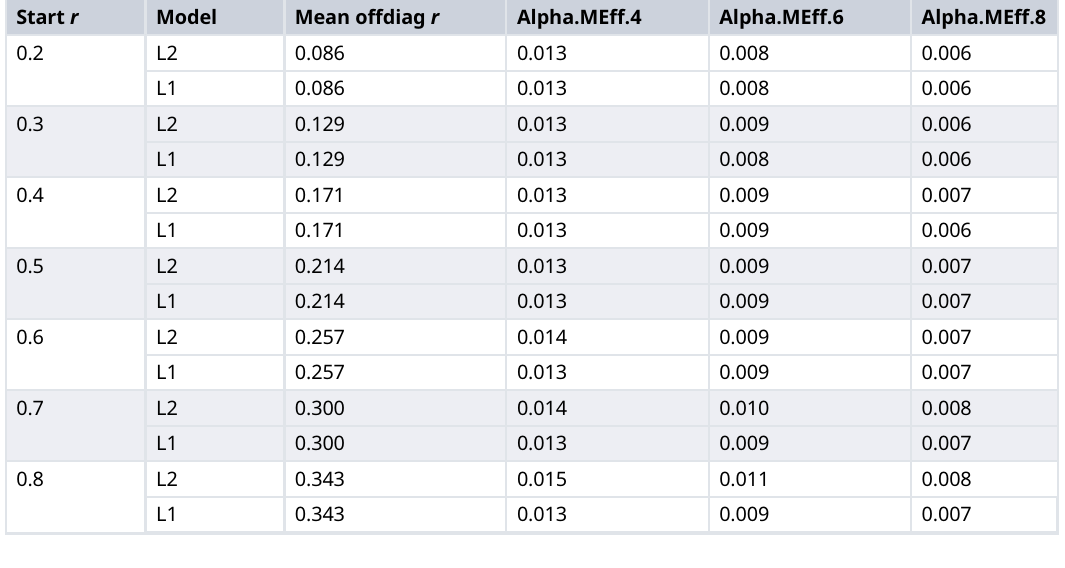
Table 3. AlphaMEff values for Model L2 (odd rows) and Model L1 (even rows), with same mean off diagonal r . For Model L2, “ Start r ” is the value for nonzero off-diagonal correlations.